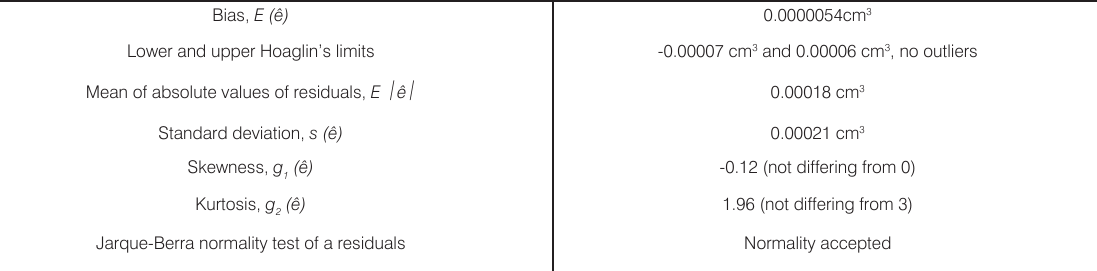
1.96 (not differing from